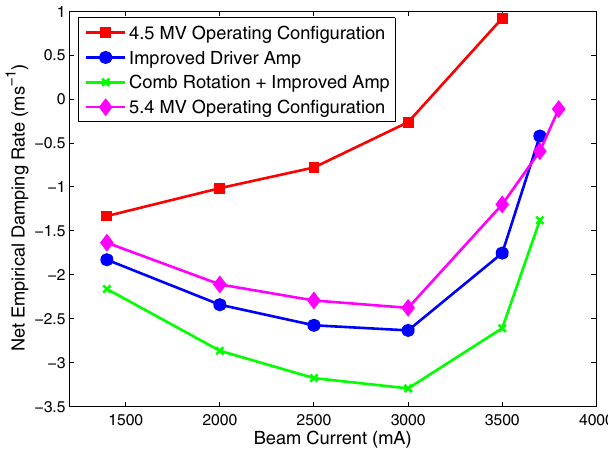
(cid:2) 2 (cid:5) for LER. l l